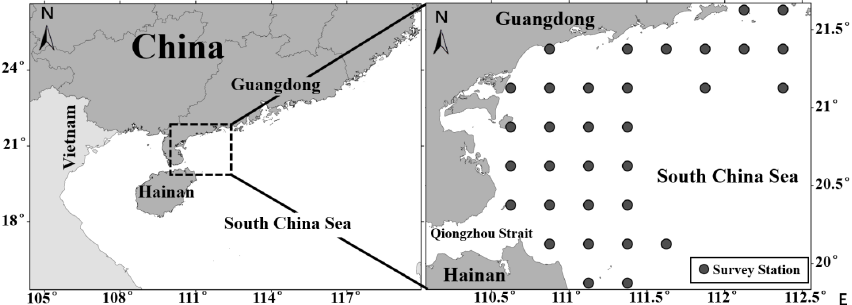
Figure 1. Research area and survey stations of spawning grounds in Western Guangdong waters (WGWs; dotted box, area of satellite data).